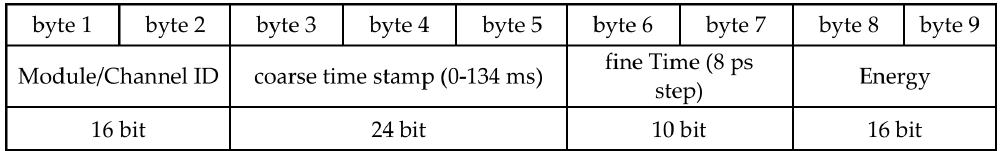
Figure 17. The 9-byte data format for each hit channel in the digitizer module.